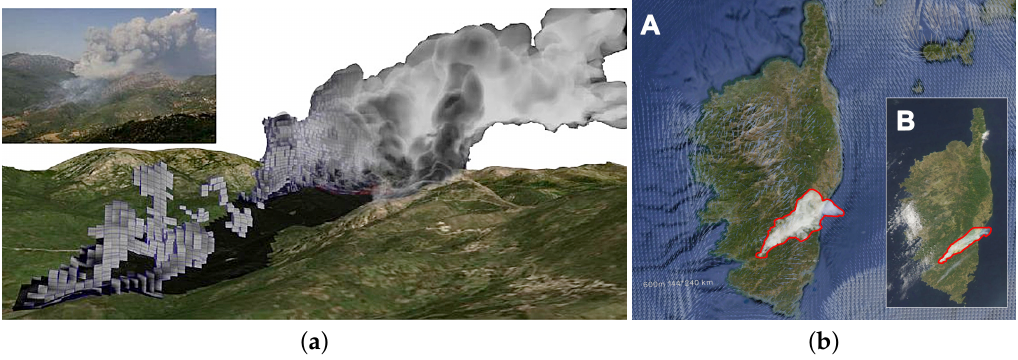
Figure 6. Simulated smoke tracer on 23 July 2009 ( a ) in the 50-m resolution domain compared to the plume’s photograph (at the top left) at 14:50 UTC and ( b ) in the 600-m resolution domain highlighted in red (A) at 15:00 UTC compared to the MODIS image (B) of Corsica at 14:50 UTC.